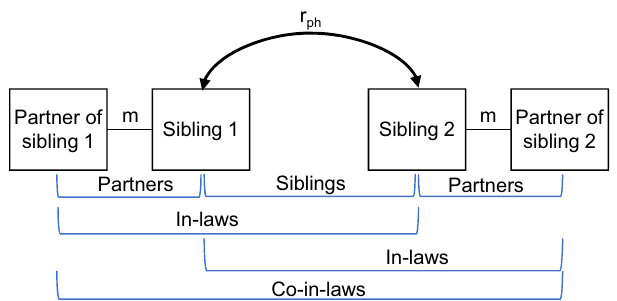
Fig. 1 Relationship terminology. We study four types of relationships, partners, siblings, siblings-in-law, and co-siblings-in-law (the respective partners of siblings). m = assortative mating, r ph = similarity between siblings. This is a conceptual model; it is not fi tted to data.